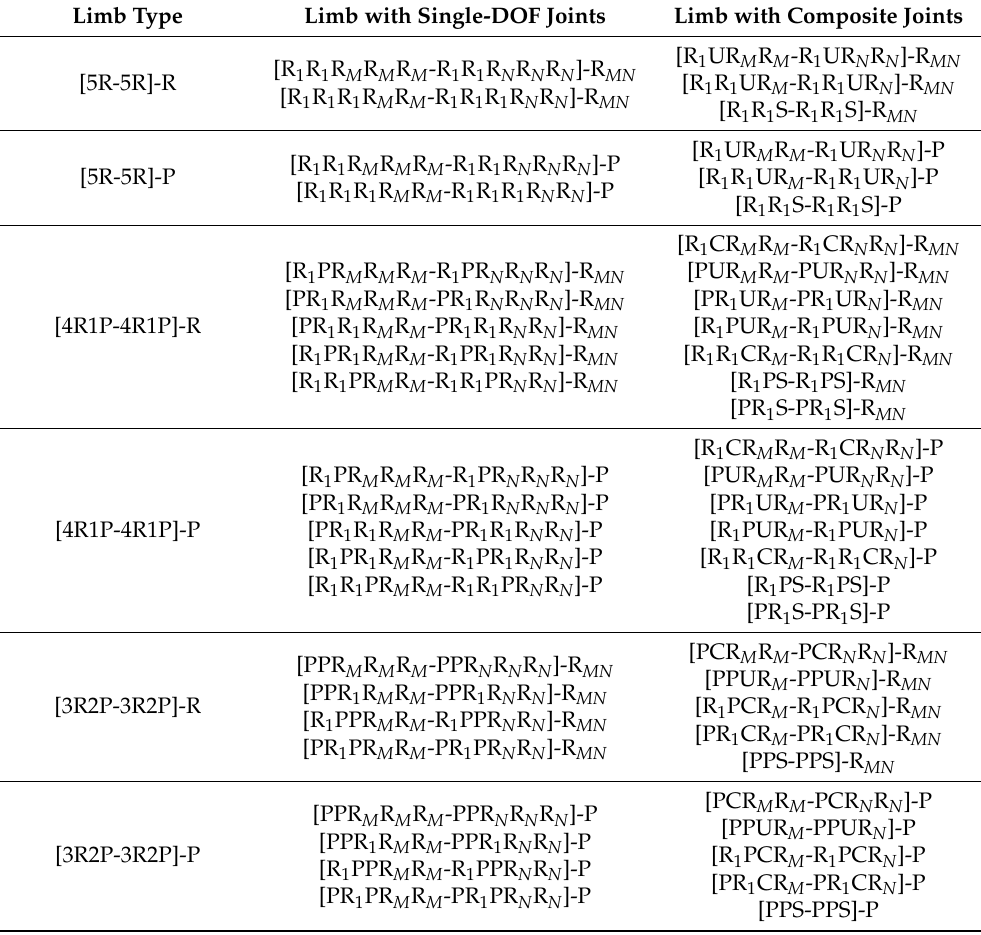
Table 3. A class of C-hybrid limbs. Limb Type Limb with Single-DOF Joints Limb with Composite